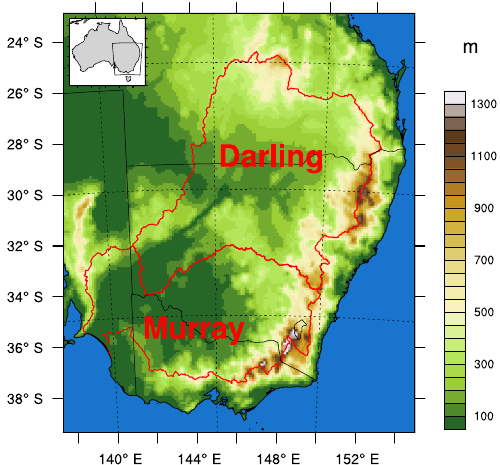
Figure 1. Model domain showing the Murray and Darling river